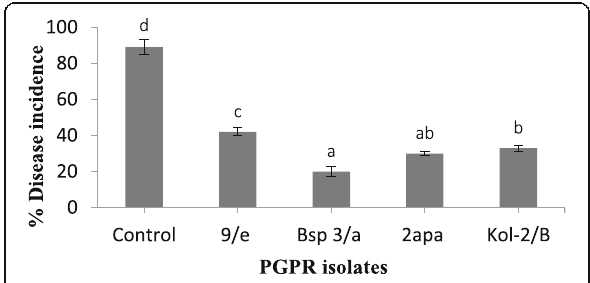
Fig. 2 Efficacy of seed biopriming on disease incidence